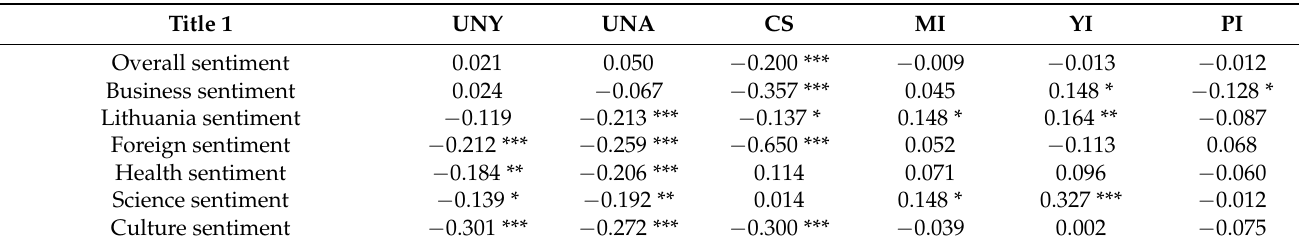
Table 3. Correlation of different categories of negative sentiment with the assessed indicators of economic